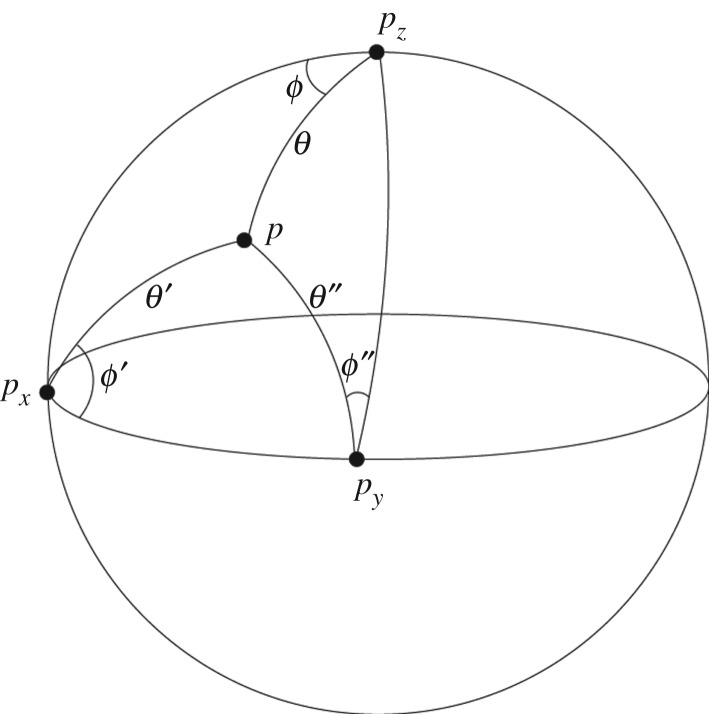
Analysis of the properties of spherical triangles formed from the points p, pz, px and py is essential to explore the consequences of this finite representation of the Bloch sphere.